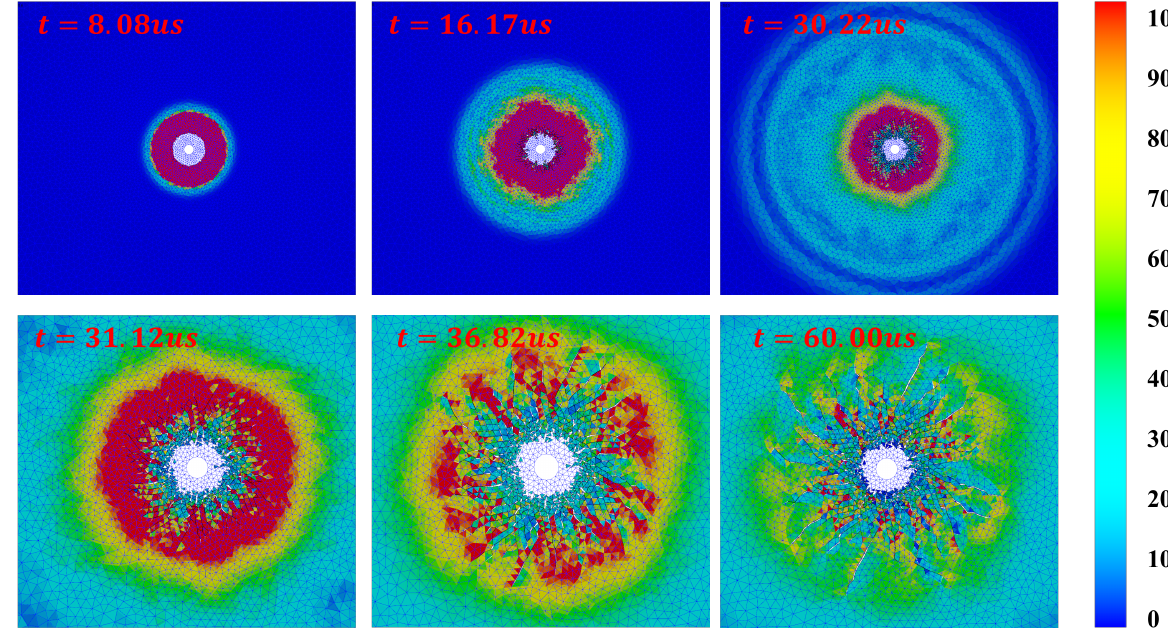
Figure 8. Mises stress of the PMMA